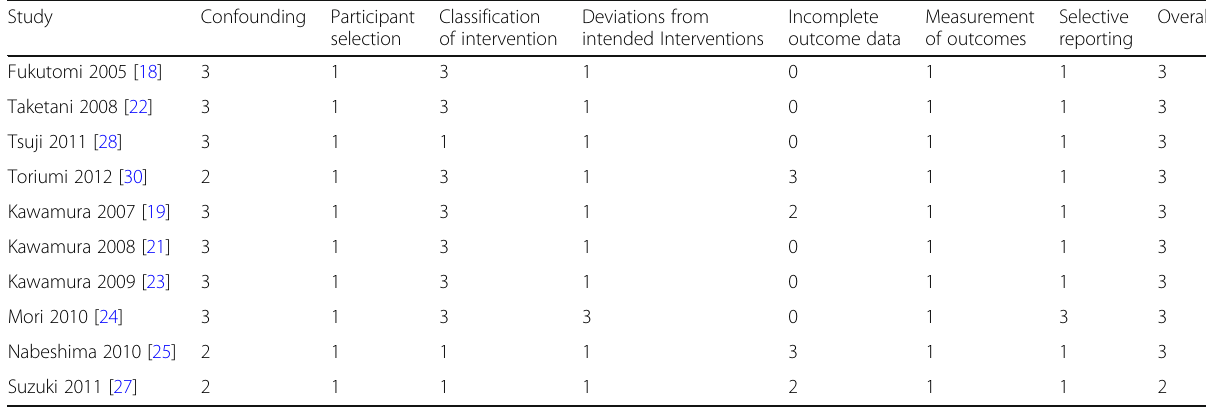
Classification Deviations from selection of intervention intended Interventions